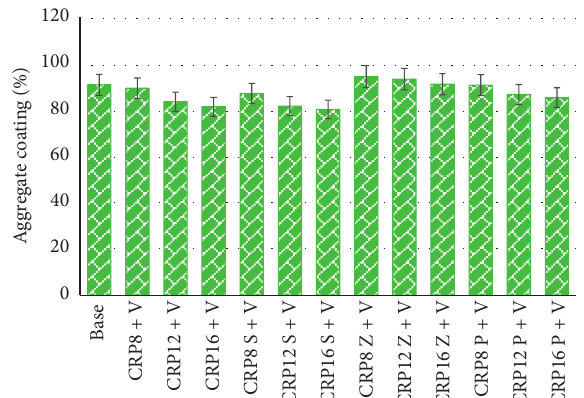
Figure 4: Aggregate coating in samples after the boiling water